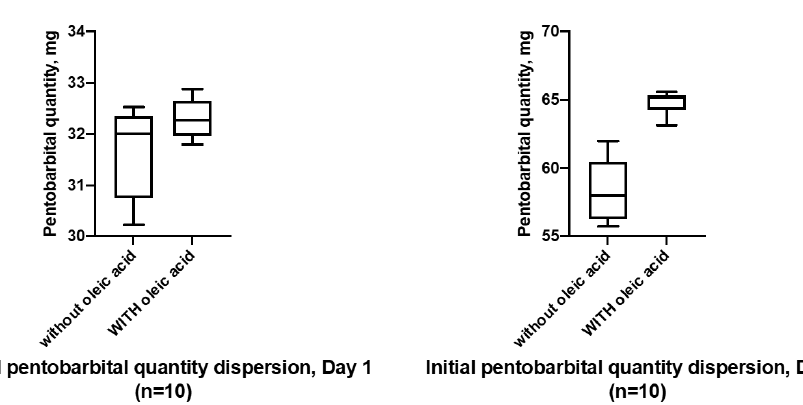
Figure 3. Initial distribution of pentobarbital quantity in the ten 30 mg and 60 mg pentobarbital suppositories analysed at day 1 (initial reference time point for the stability study).